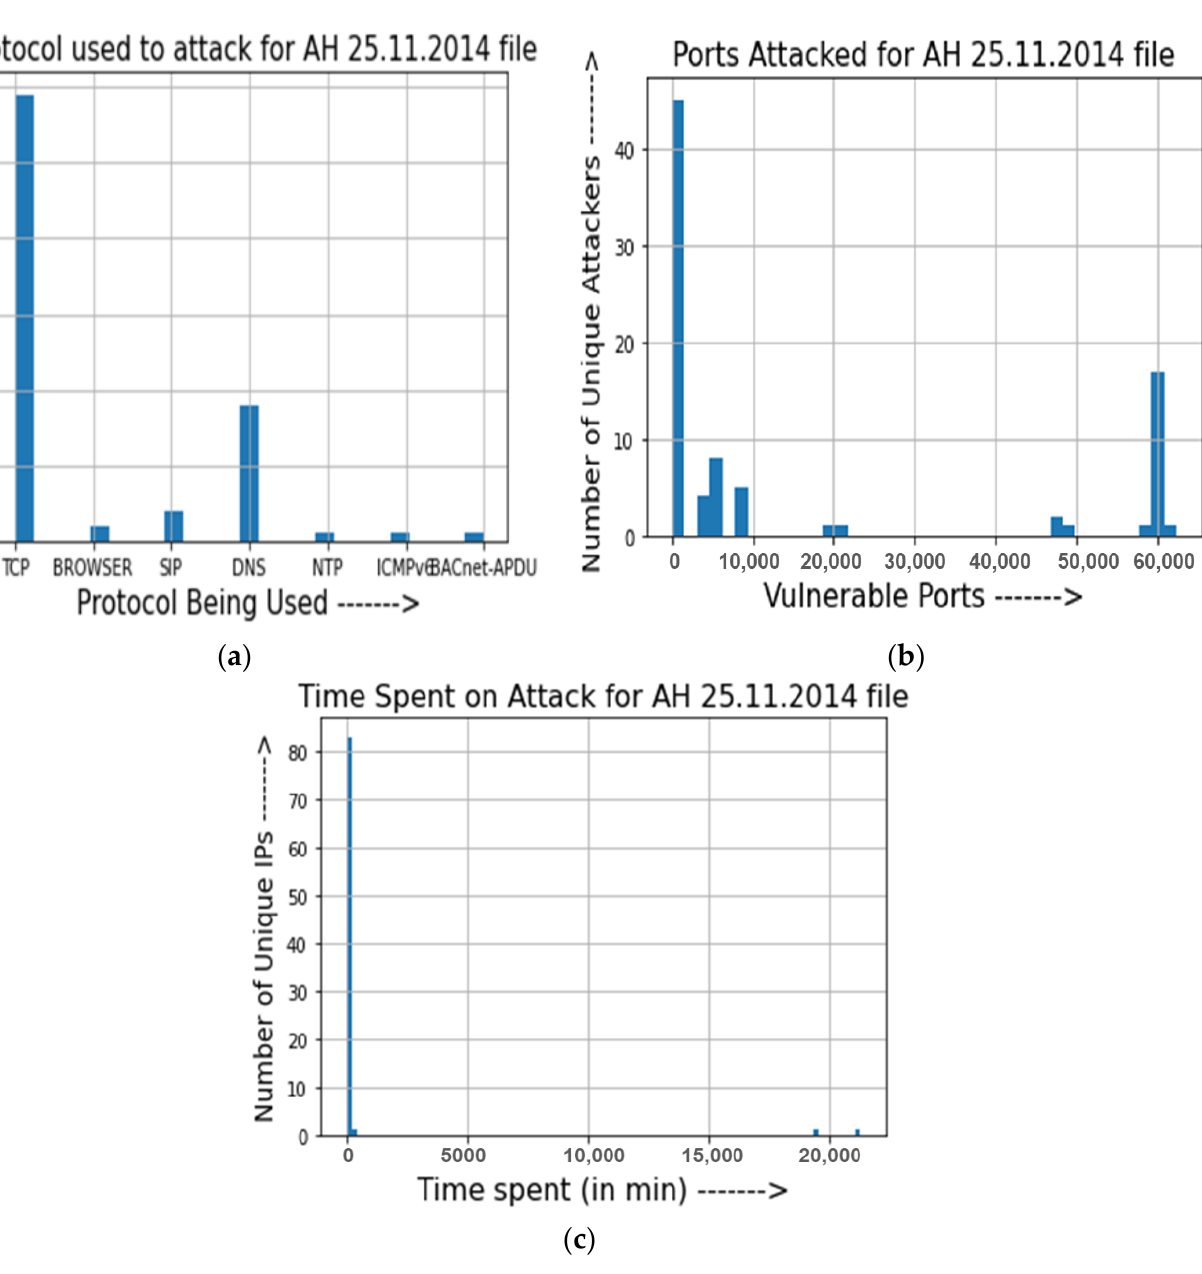
Figure 7. Experimental Results for PCAP file (AH 25.11.2014). ( a ) Number of Unique I.P.s vs. Protocol being used; ( b ) Number of Unique Attackers vs. Vulnerable Ports; ( c ) Number of Unique I.P.s vs. Time Spent.